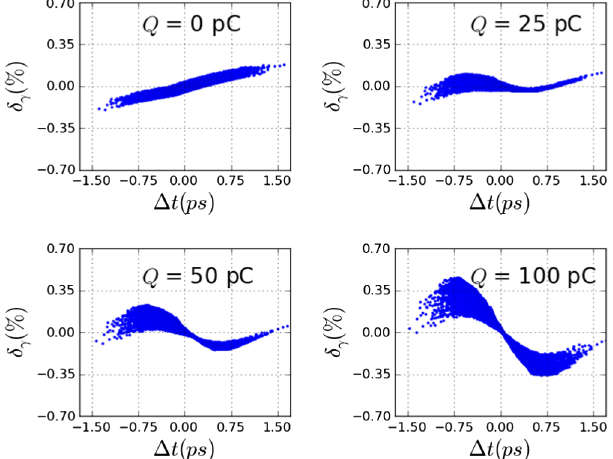
FIG. 2. Negative energy chirp downstream of the BNL photo- cathode rf gun increases with the increase of the bunch charge due to the increase of space charge effects. Simulation results come from PARMELA . In these plots, particles located at Δ t > 0 correspond to the tail particles of the bunch.